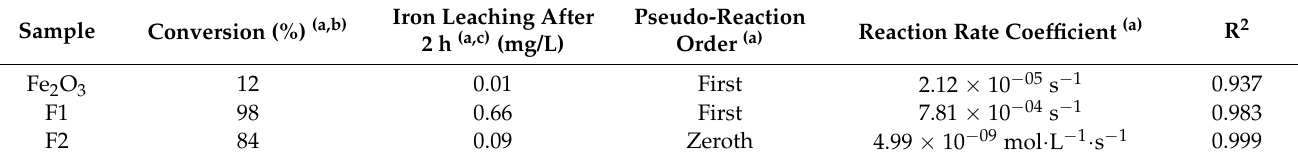
(a) Iron content of all samples used was 100 mg/L, (b) conversion after 2 h in RB5 assay, (c) determined by